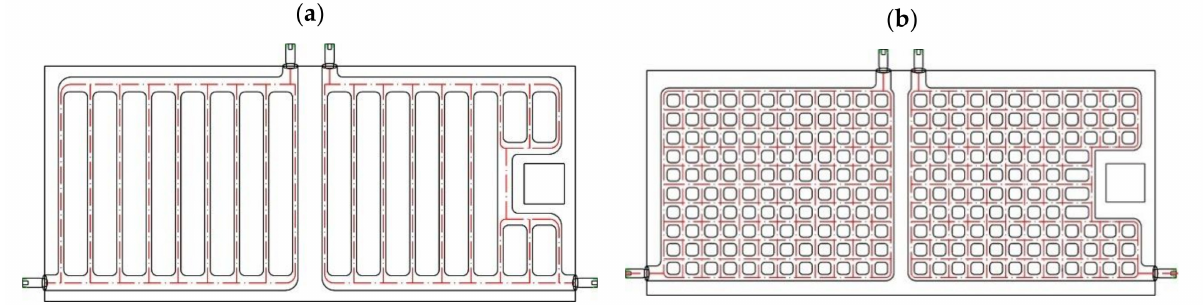
Figure 17. ( a ) Harp-channel absorber plate; ( b ) grid-channel absorber plate (reprinted from [101], with permission from